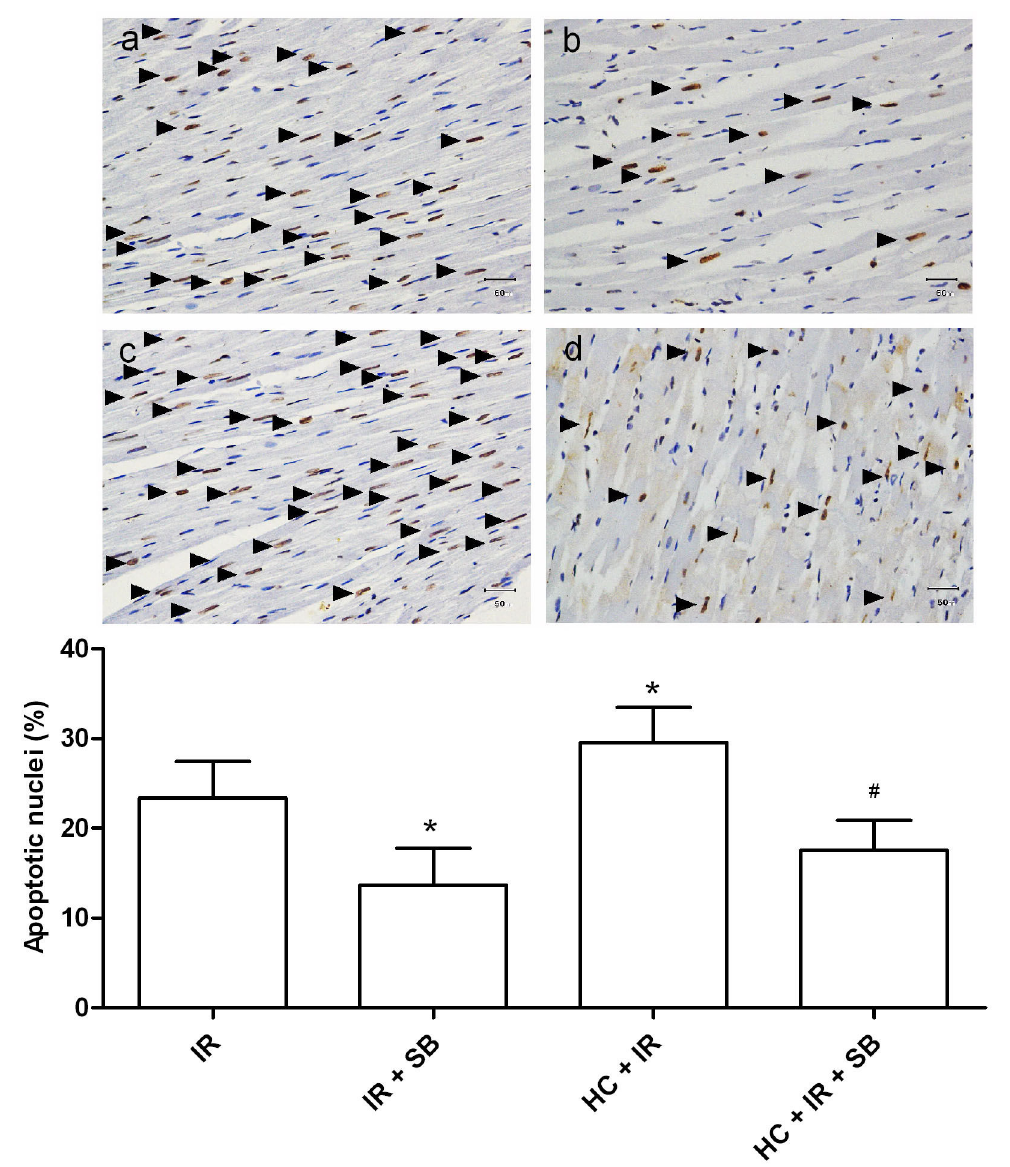
Figure 6. Effects of GSK3β inhibitor SB216763 on apoptosis expressed as a percent of total nuclei in tissue sections from rat hearts exposed to ischemia-reperfusion (TUNEL staining, 400×). a normocholesterolemic ischemia reperfusion group (IR), b normocholesterolemic SB216763-treated group (IR + SB), c hypercholesterolemic ischemia reperfusion group (HC + IR), d hypercholesterolemic SB216763-treated group (HC + IR + SB). IR: ischemia reperfusion; SB: SB216763; HC: hypercholesterolemia. Data are mean ± SD, n = 6 hearts/group. * P < 0.05 vs . IR; # P < 0.05 vs . HC + IR. doi: